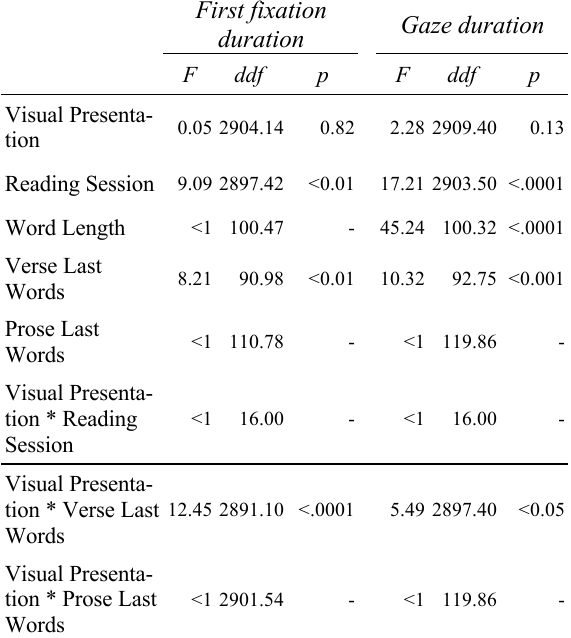
Table 1. Mixed model parameters for two duration-based eye tracking measures (first fixation duration and gaze duration) reflecting early processes of visual word recognition and orthographic/lexical access (lexical level).